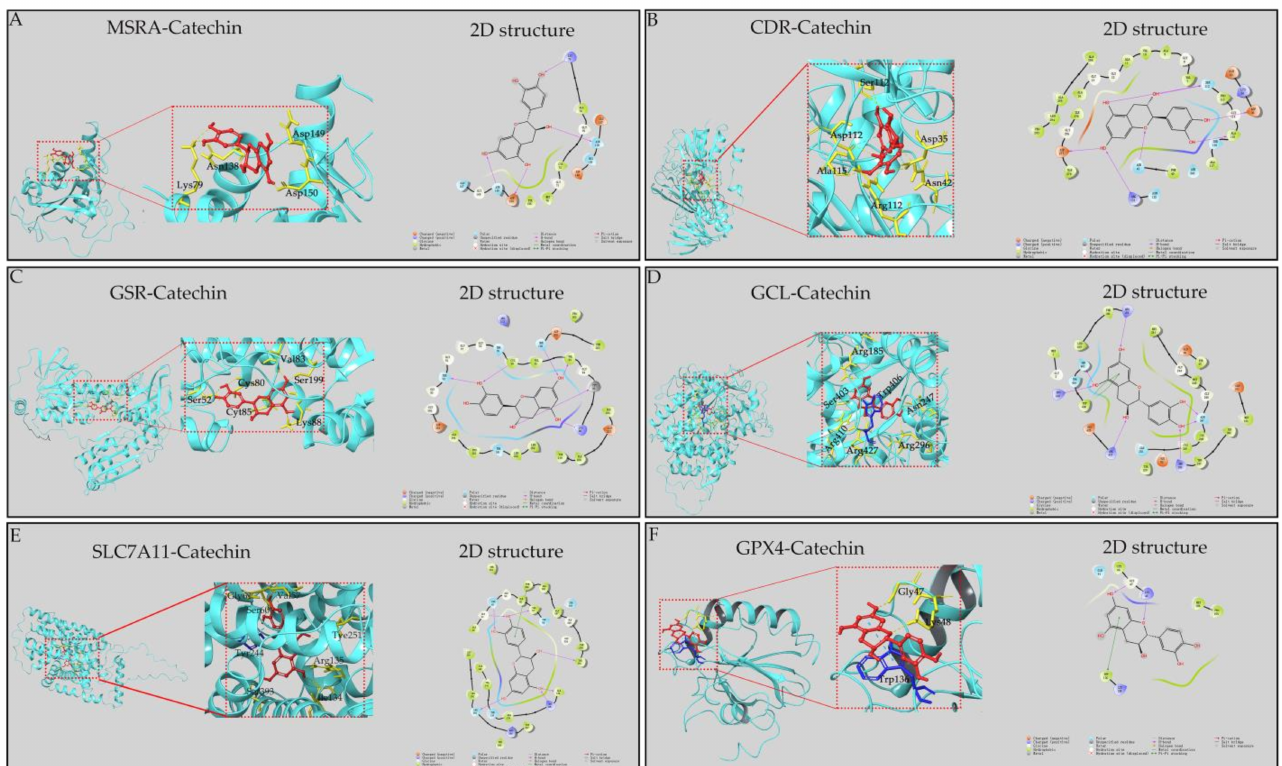
Figure 4. Molecular binding modes of catechin with proteins were presented by 3D and 2D structures. ( A ) Binding modes of MSRA-catechin complex. ( B ) Binding modes of CDR-catechin complex. ( C ) Binding modes of GSR-catechin complex. ( D ) Binding modes of GCL-catechin complex. ( E ) Binding modes of SLC7A11-catechin complex. ( F ) Binding modes of GPX4-catechin